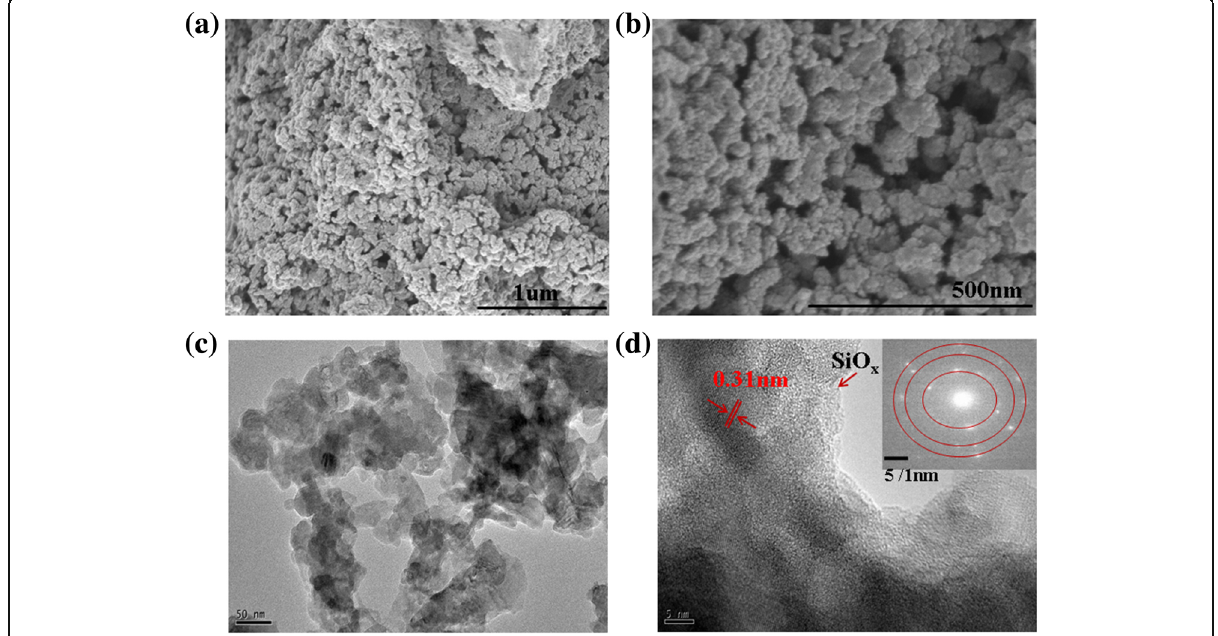
Fig. 2 a , b SEM images and c , d TEM images of pSi (inset in d shows SAED